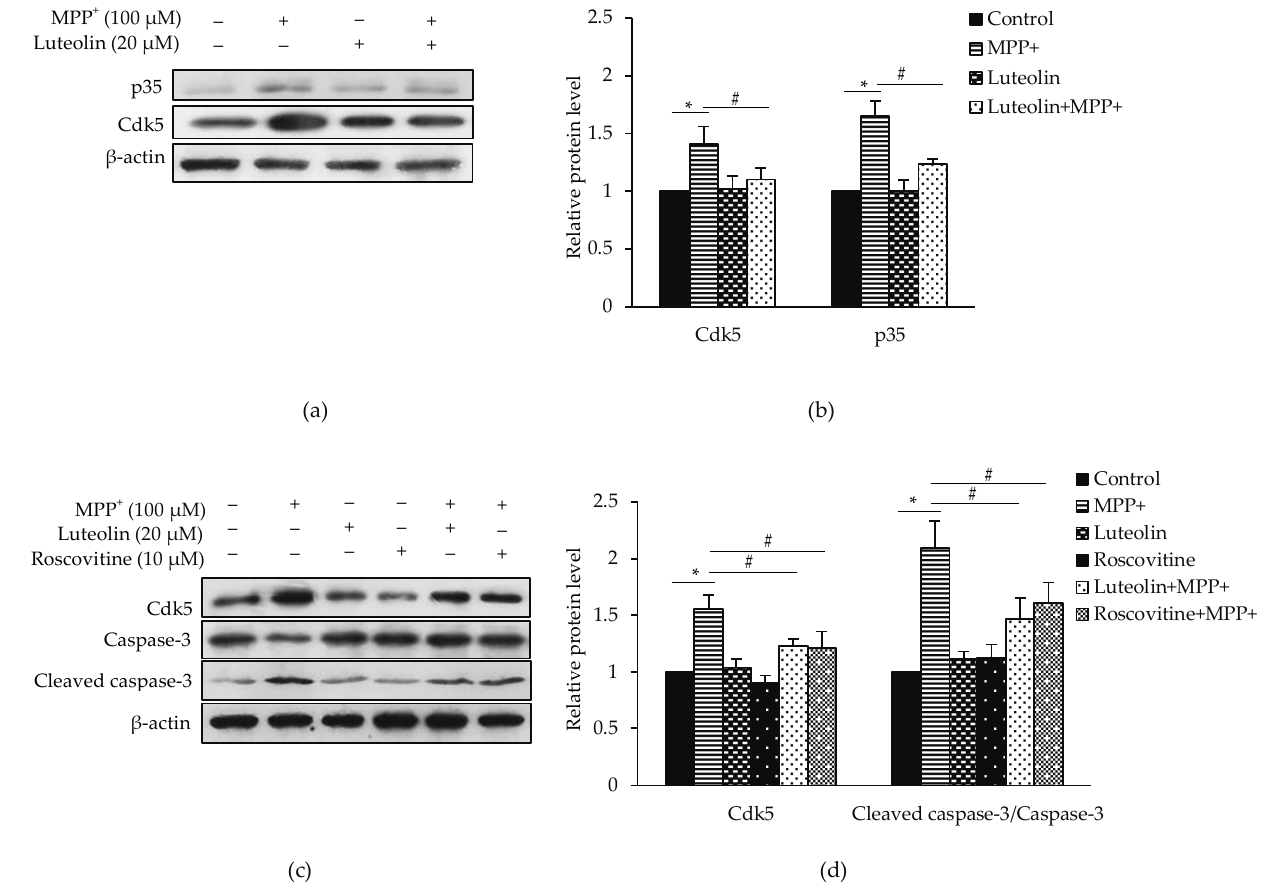
Figure 6. Luteolin ameliorated MPP + -induced Cdk5 hyperactivity in SH-SY5Y cells. Cells were pre-treated with 20 µ M luteolin for 1 h, followed by treatment with 100 µ M MPP + for 24 h. ( a ) Expressions of Cdk5 and p35 were analyzed by western blotting. ( b ) Quantification of Cdk5 and p35 was shown in the bar graph. Cells were pre-treated with 20 µ M luteolin and 10 µ M roscovitine for 1 h, followed by treatment with 100 µ M MPP + for 24 h. ( c ) Expressions of Cdk5 and cleaved caspase-3/caspase-3 were analyzed by western blotting. ( d ) Quantification of Cdk5 and cleaved caspase-3/caspase-3 was shown in the bar graph. Data were normalized using β -actin as control. Results presented as the mean ± SD for triplicated independent experiments. Differences are statistically significant at * p < 0.05 versus the control group, and # p < 0.05 versus the MPP + group.